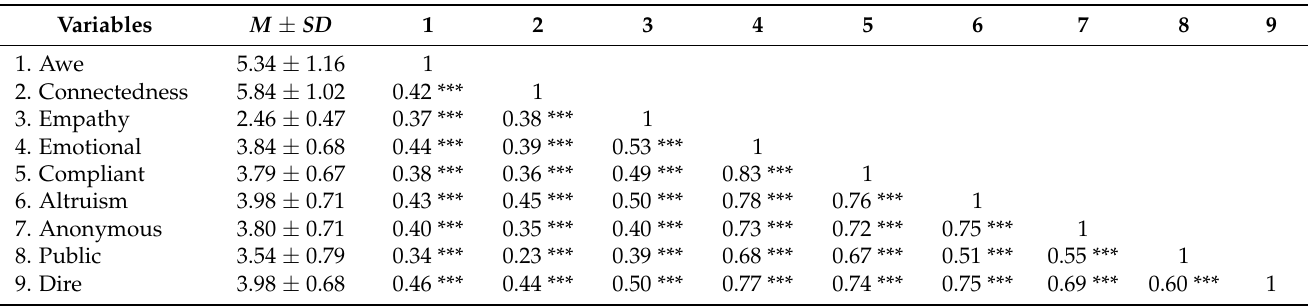
Table 1. Descriptive statistics and correlations among the variables.